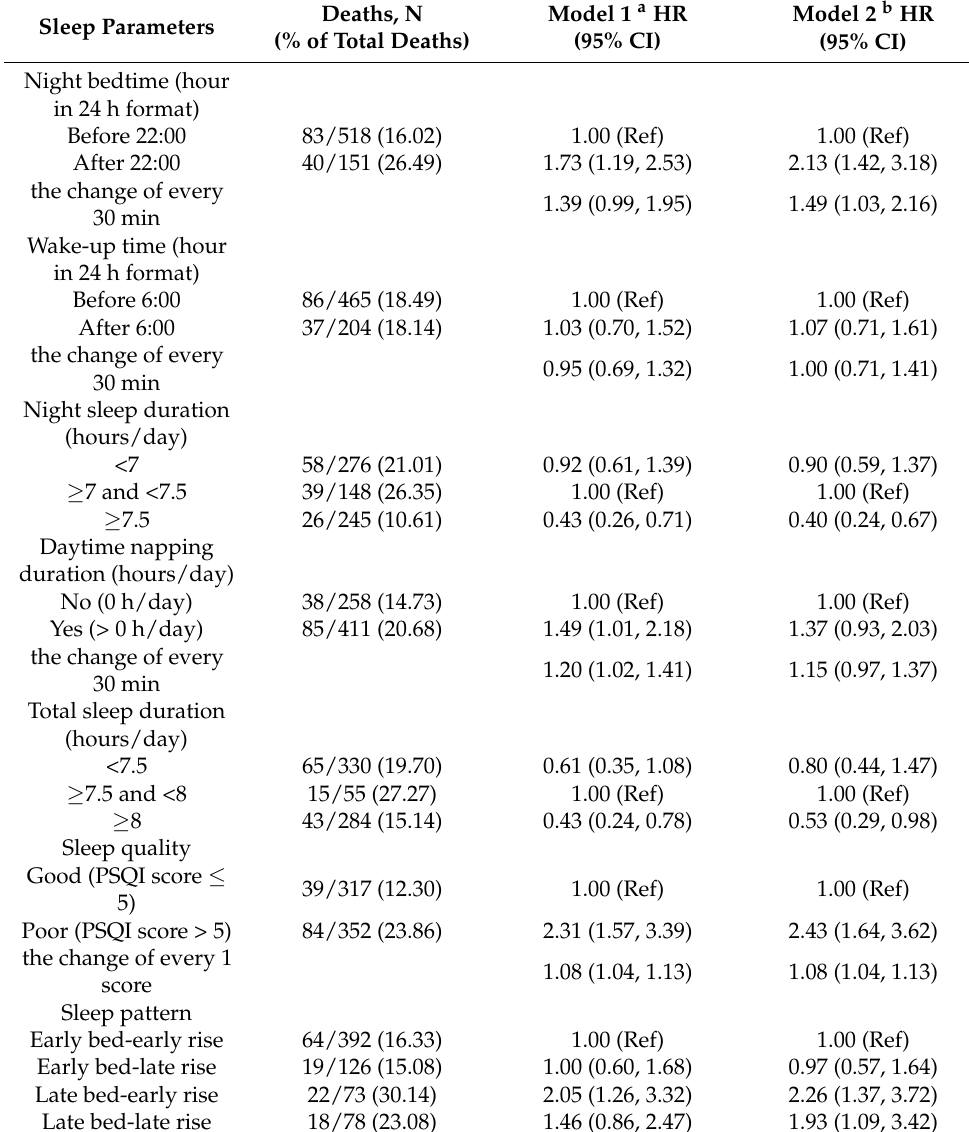
Table 3. Associations between pre-diagnosis sleep status and overall survival among ovarian cancer